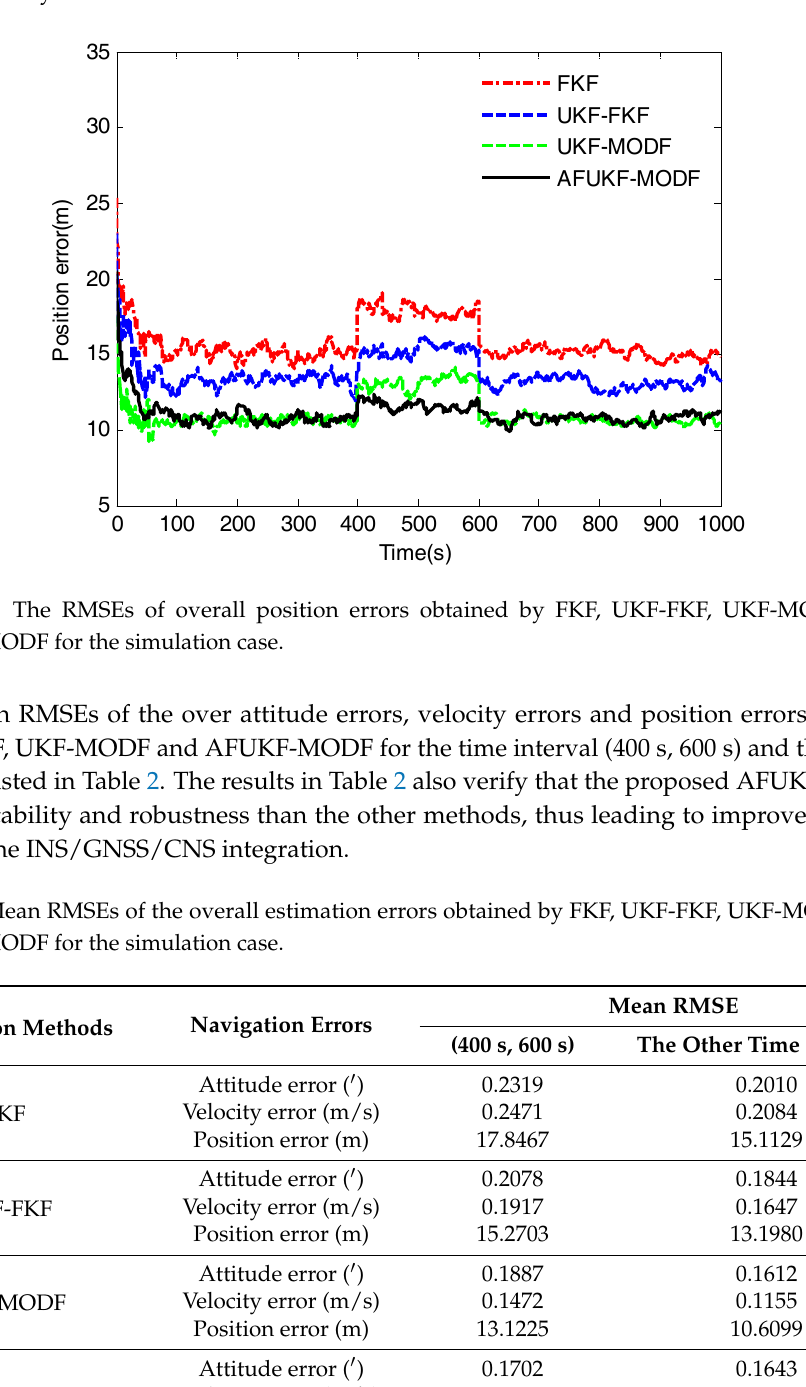
15 of 21 Figure 4. The RMSEs of overall velocity errors obtained by FKF, UKF-FKF, UKF-MODF and AFUKF- MODF for the simulation case. During the time interval (400 s, 600 s), due to the influence of the introduced process-modeling error, the navigation accuracy of FKF, UKF-FKF and UKF-MODF degrades seriously. This is because these three methods do not have the ability to resist the influence of process-modeling error on the fusion solution. The estimation RMSEs in attitude, velocity and position are around 0.2319  , 0.2471